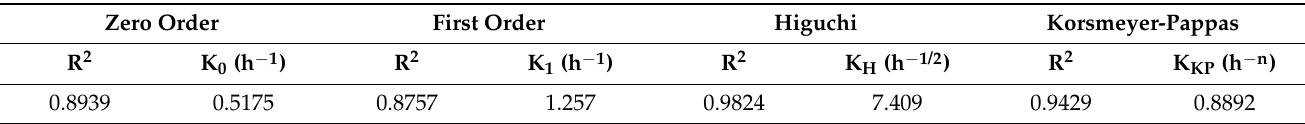
Table 3. Release kinetics of